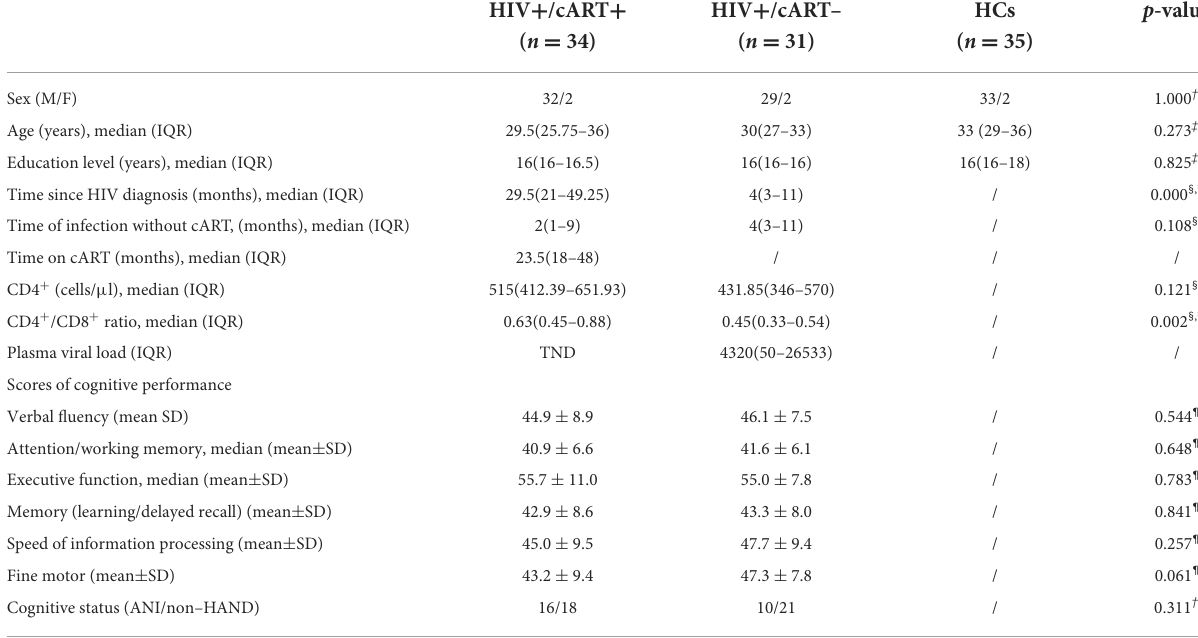
TABLE 2 Demographic, clinical variables, and neuropsychological